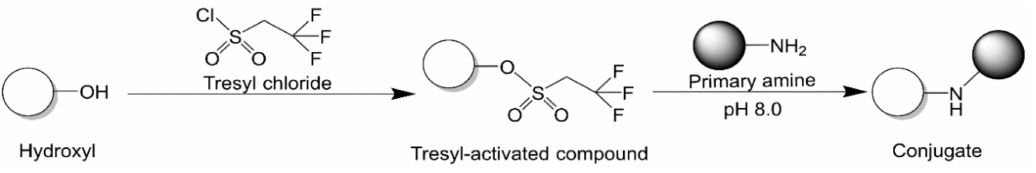
Figure 10. Tresyl chloride activation.